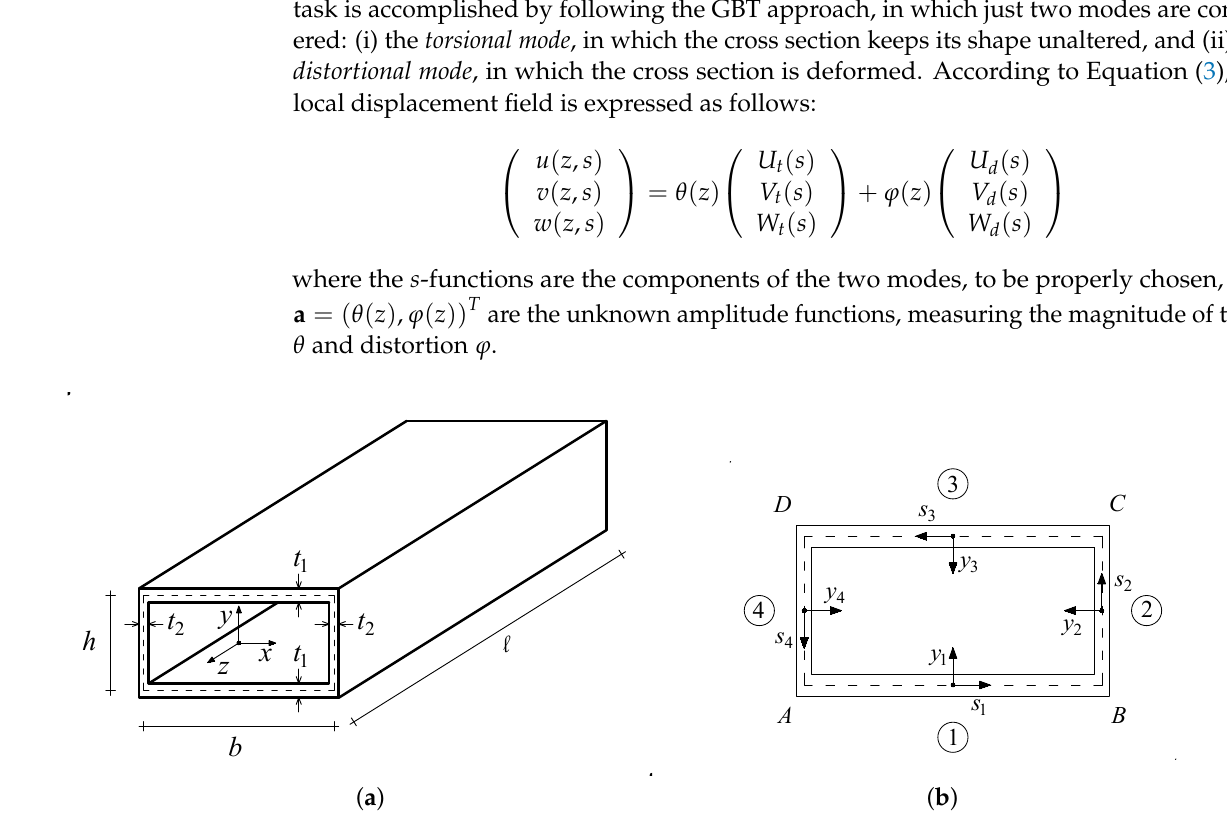
Figure 1. Box-girder: ( a ) geometry; ( b ) element numbering and local systems of